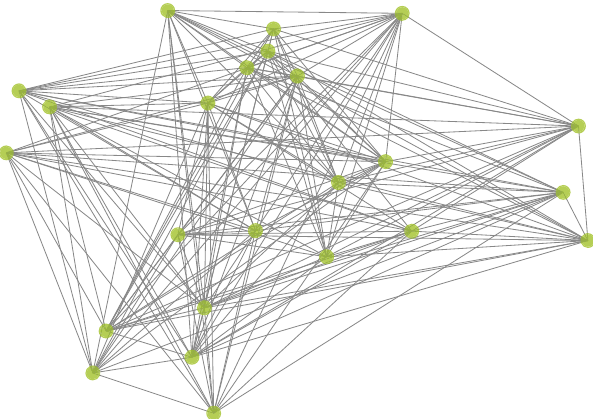
Figure 2: Block network composed of eight of the same 3-node